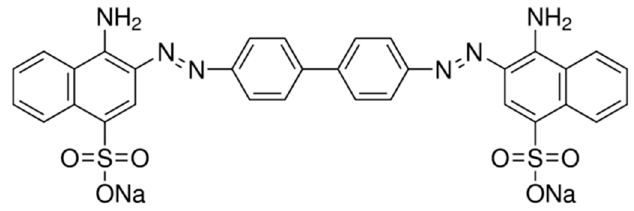
Figure 1. Molecular structure of Congo Red (CR) dye.